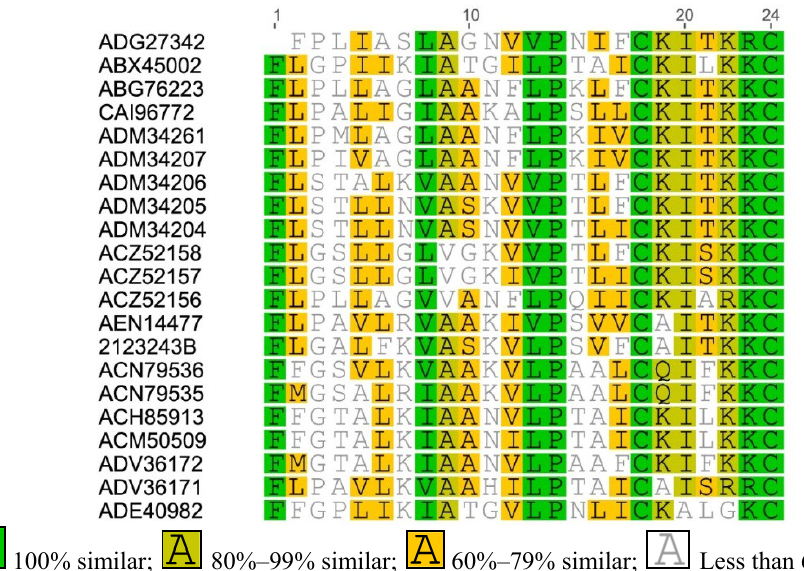
Figure A1. Multiple sequence alignment of Brevinin-1 from Asian frogs.